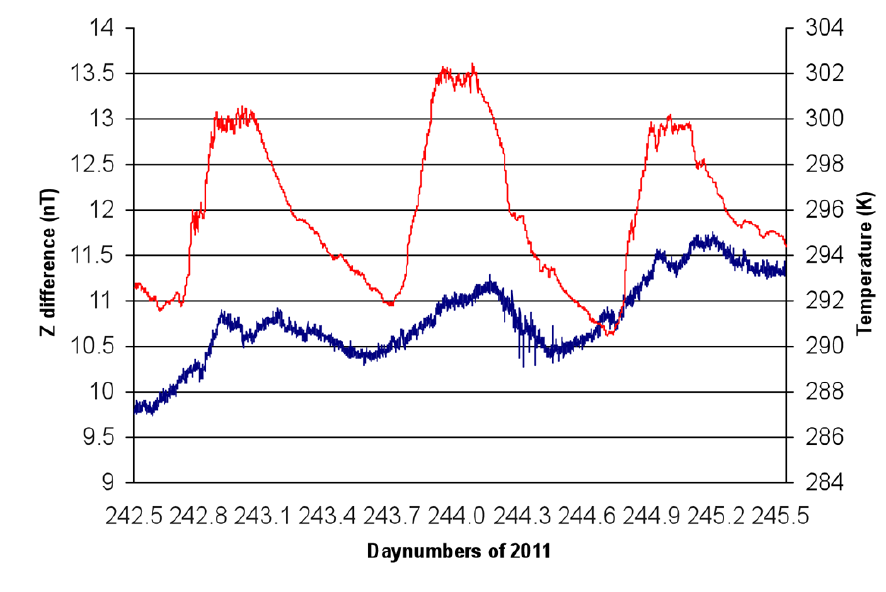
Figure 9. Difference of vertical components between the preliminary data of Tihany observatory and the DIDD record (blue) and the environmental temperature (red).